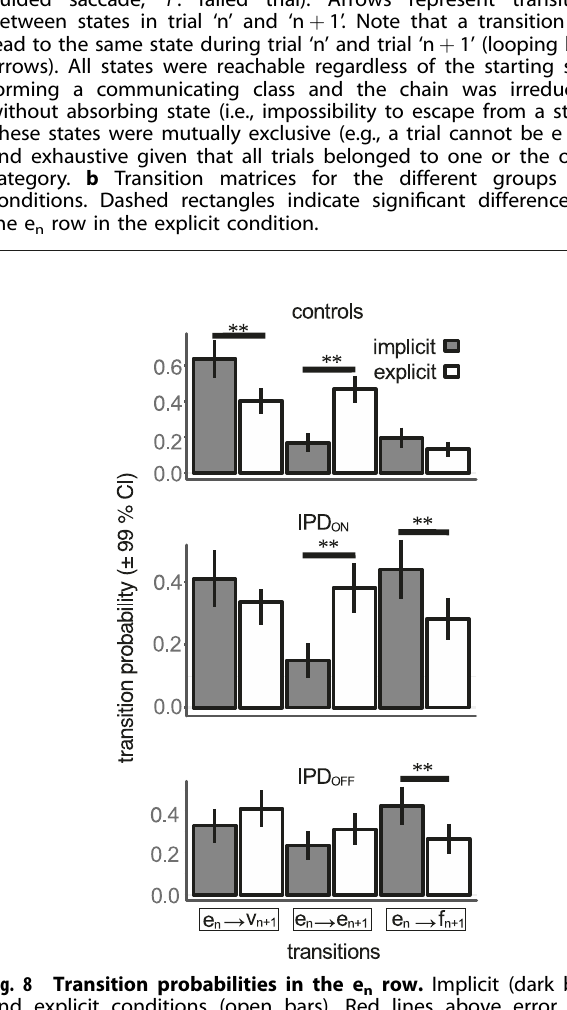
Fig. 8 Transition probabilities in the e n row. Implicit (dark bars) and explicit conditions (open bars). Red lines above error bars indicate non-overlapping 99% con fi dence intervals (i.e., signi fi cant difference p < 0.01) between the implicit and explicit conditions using the method of Schenker &